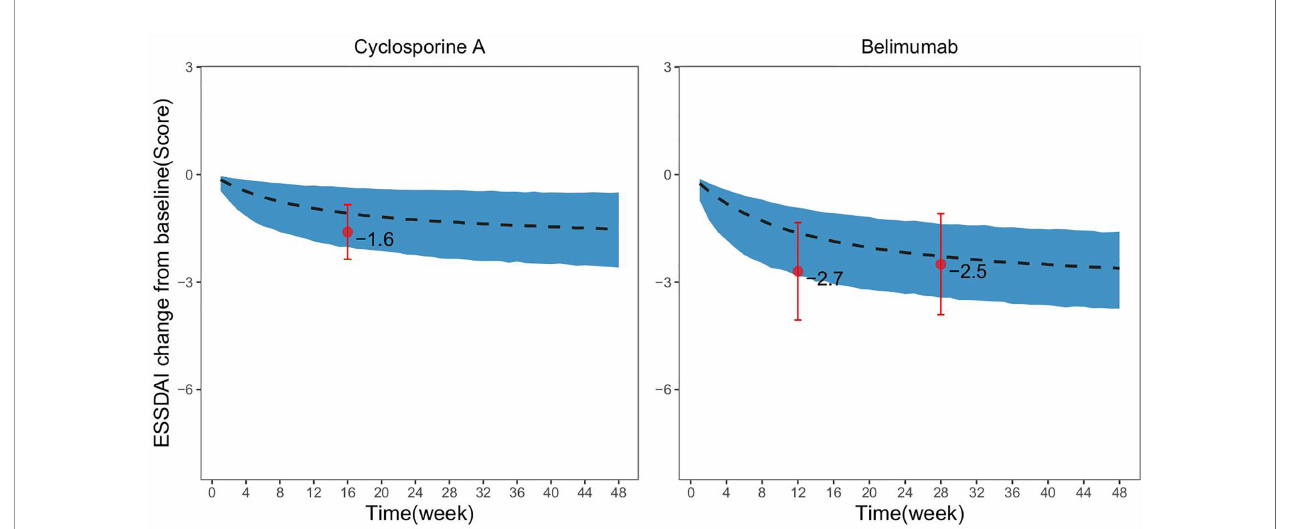
FIGURE 4 | Comparison of drug ef fi cacy and virtual placebo response distribution in single-arm trials. The dashed black line in the fi gure represents the typical value of the placebo response at the same baseline as predicted by the model, the shadow areas represent its 95% CI, and the points represent the actual observed values of the drug effect in the single-arm trial, the error bars represent SE for the actual observed